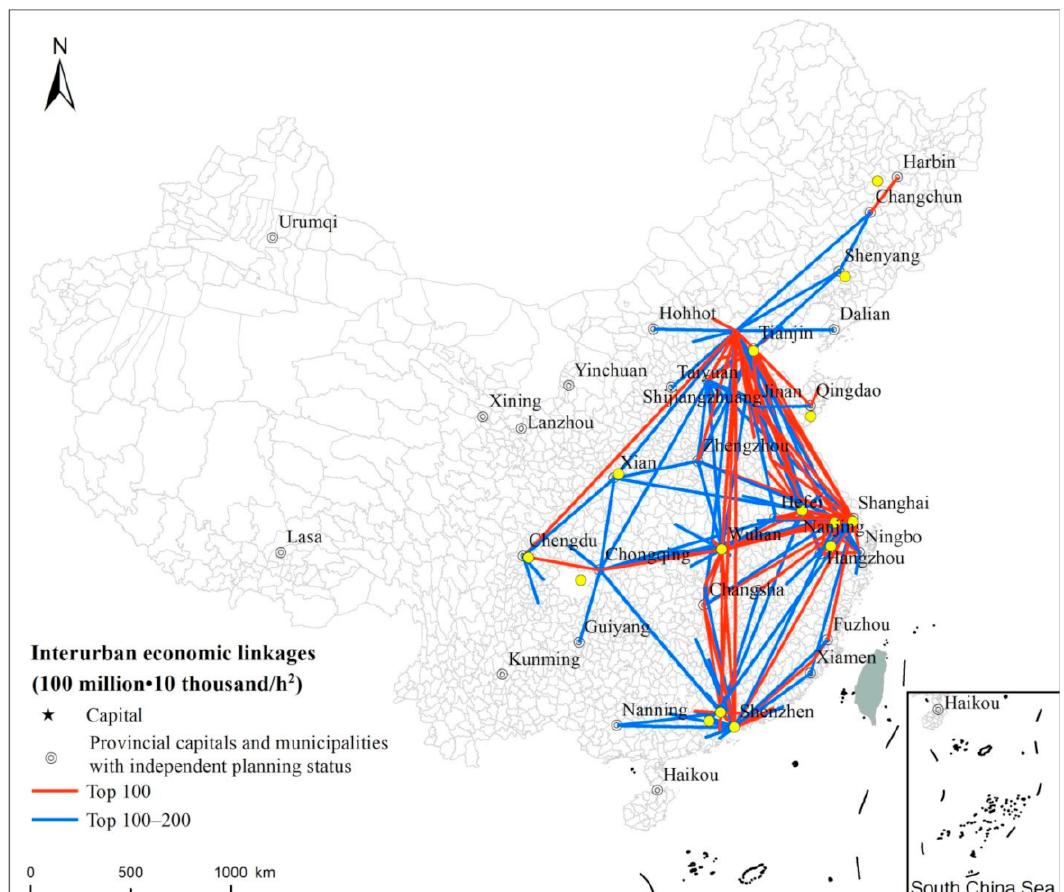
Figure 7. Spatial distribution of the top 200 cities ranked by interurban economic